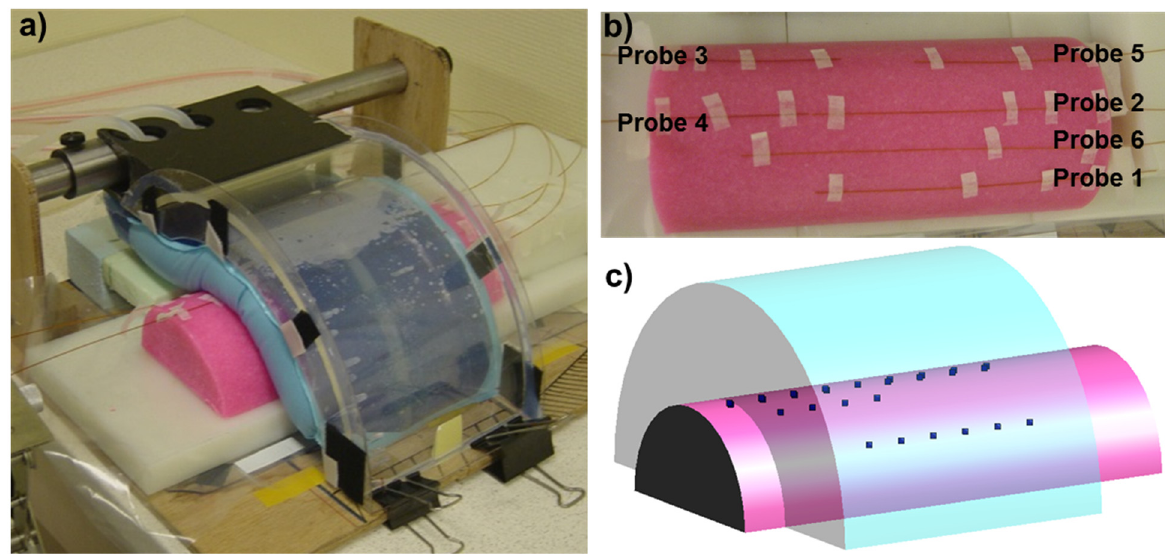
Figure 1. HYPERcollar3D water bolus heat transfer coefficient ( a ) measurement setup, ( b ) top view with fiber-optic probes location, ( c ) simulation SEMCAD X setup.